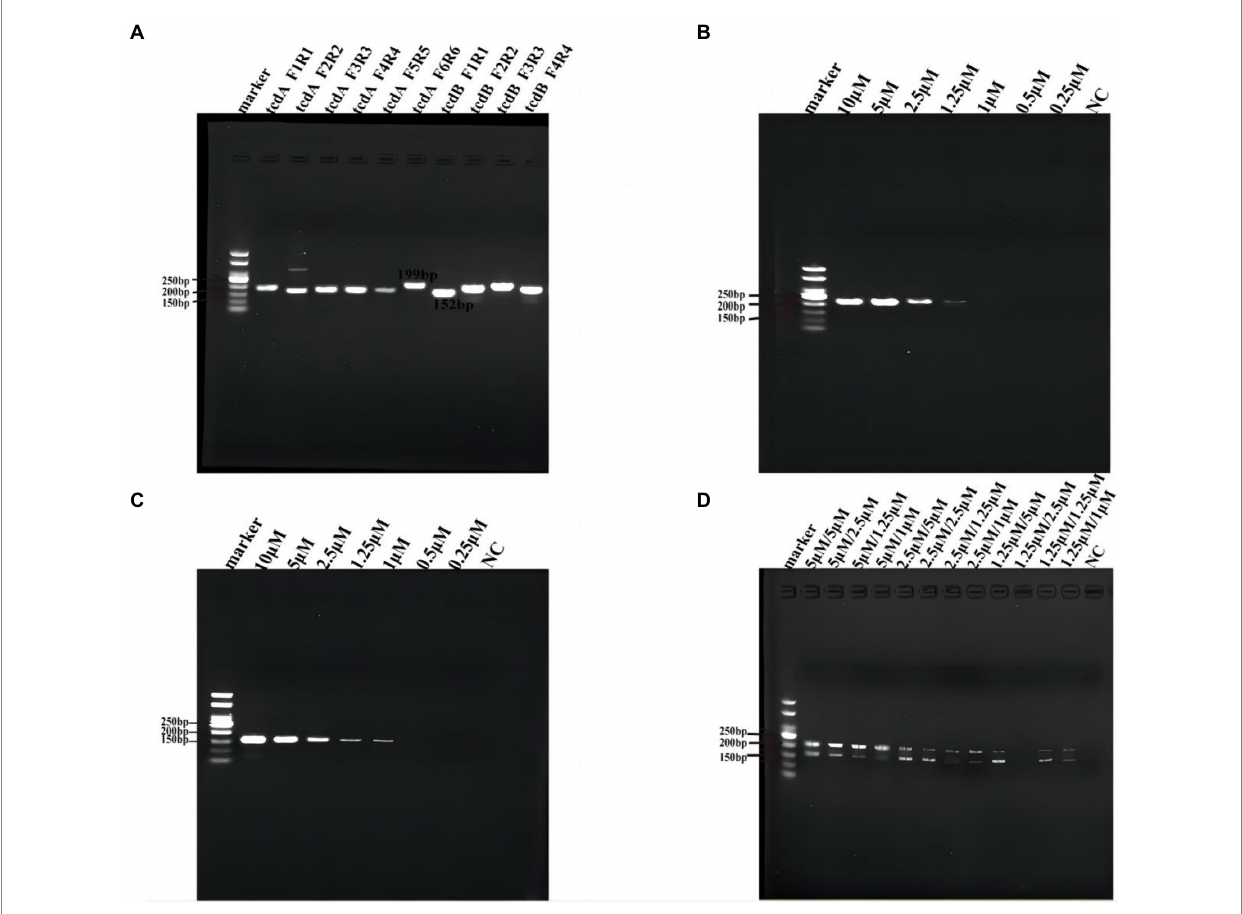
FIGURE 2 Primer optimization for multiplex RPA. (A) Six pairs of primers for tcdA and 4 pairs of primers for tcdB were tested by RPA. (B) Optimization of primer concentration for tcdA gene. (C) Optimization of primer concentration for tcdB gene. (D) Primer concentration cross-screening. NC, negative control, which nuclease-free water as template for